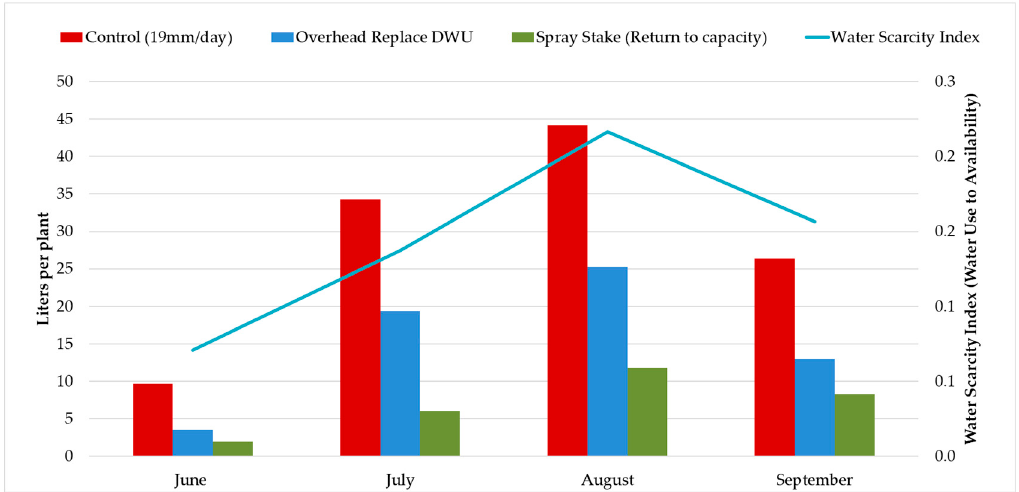
Figure 2. The left y -axis shows monthly water scarcity footprint of irrigation water applied (WSF iwa ) of selected woody plant grown in 10.2 L containers for from data collected in June through September of 2018, under four irrigation regimens in a model research nursery in Michigan. The right y -axis shows the Water Scarcity Index using the Water Use to Availability (WTA) method [39].